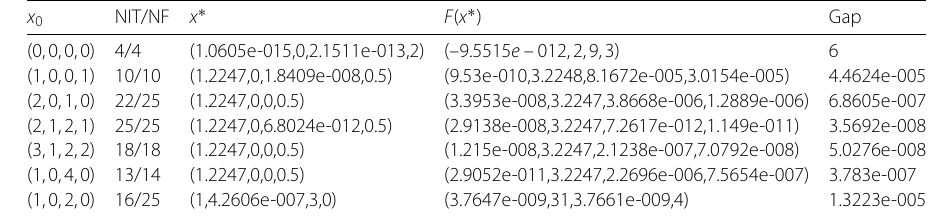
Table 5 Numerical results of Example